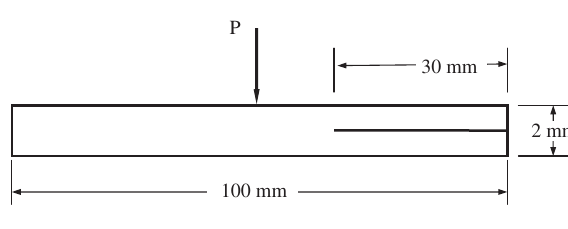
Figure 10 Specimen dimension.